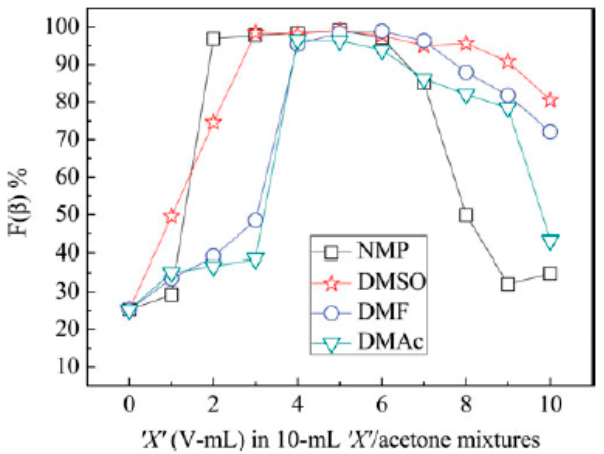
Figure 5. Calculated fractions of β -phase of the above electrospun membranes as a function of mixed solvents with the different “ X ”/acetone volume ratios for the corresponding 16 wt.% PVDF solutions. The “ X ” stands for the fraction of one of the four solvents. Reprinted with permission from [73].